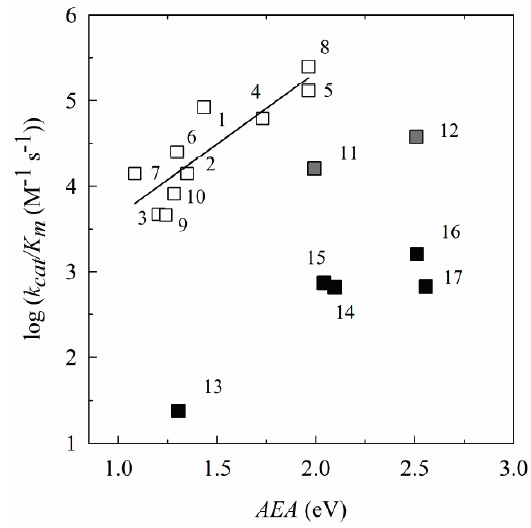
Figure 5. The dependence of the log of the apparent second-order rate constants (k cat /K m ) of reduction of BFXs (compounds 1–10, open squares), annelated BFXs (Compounds 11–12, filled gray squares) and model NACs (Compounds 13–17, filled black squares) by NAD(P)H:quinone oxidoreductase (NQO1) upon their AEA values, assessed using B3LYP/6-311+G(d,p) method. The linear correlation is defined for BFXs, omitting annelated BFX Compounds 11 and